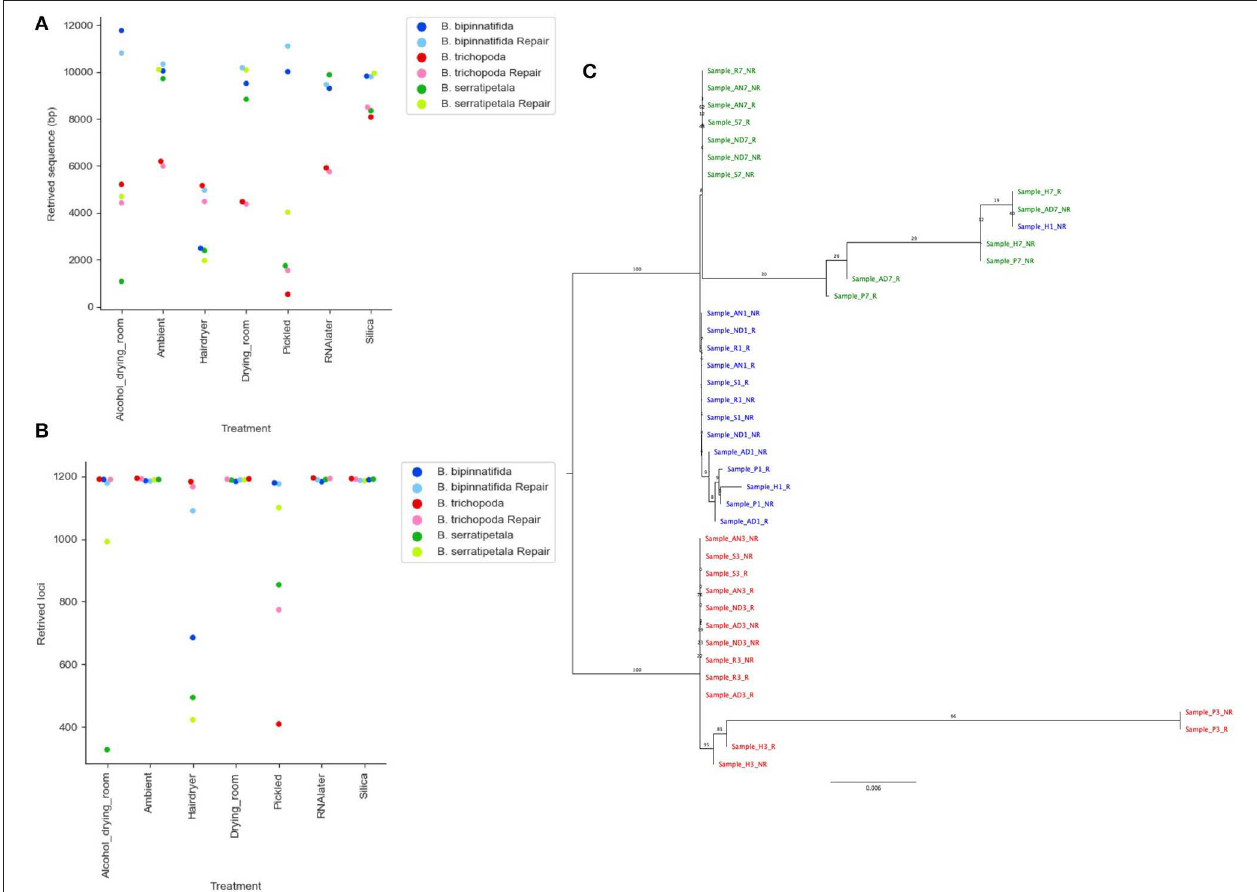
FIGURE 8 | Effect of stricter quality filtering on sequence recovery and phylogenetic analysis. (A) Length of sequence recovered using strict quality filters (QUAL > 160). (B) Number of loci recovered using strict quality filters (QUAL > 160). (C) Phylogram of consensus sequences from each sample. Produced using RAxML from a trimmed Mafft alignment of a concatenation of all consensus bait sequences using strict quality filters (QUAL > 160). Samples from B. bipinnatifida are colored in blue, B. serratipetala in green and from B. trichopoda in red. B. trichopoda was designated outgroup. Numbers on the branches represent ML Bootstrap supports. In (A,B) , lighter shades are used for repaired